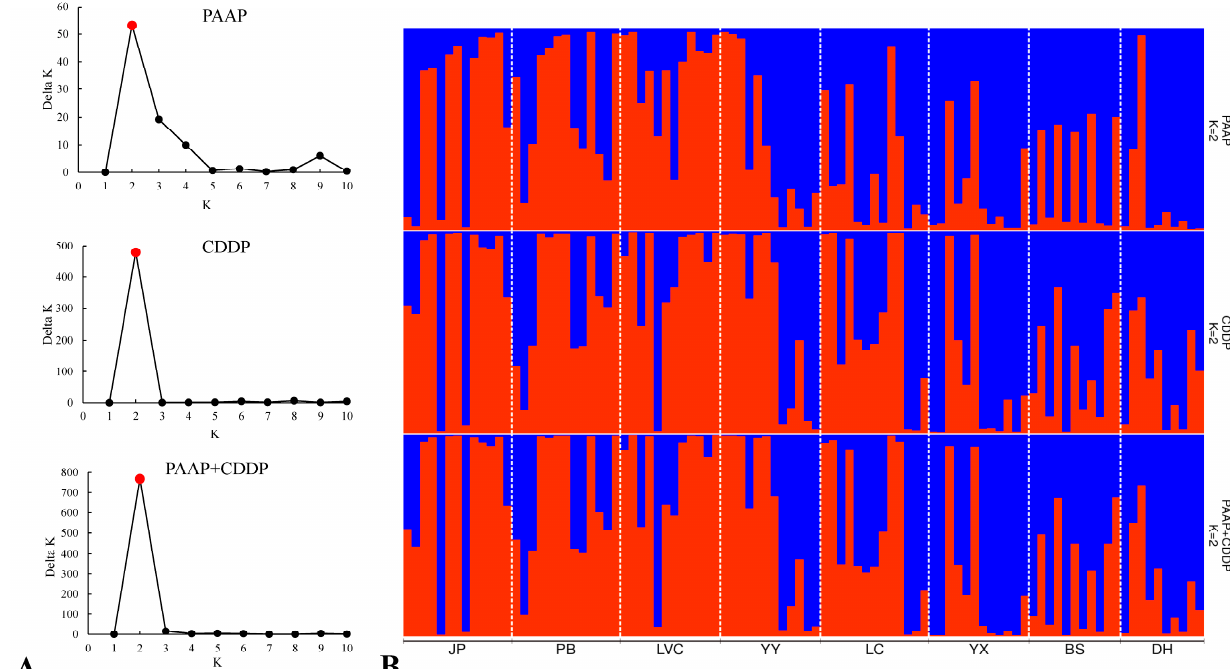
Figure 7. Graphical representation of population structure using STRUCTURE v2.3.4 and Structure Harvester v6.0 programs. ( A ) The median and variance of the estimated probability value for each K value; ( B ) Population structure of 96 A. tsao-ko accessions.